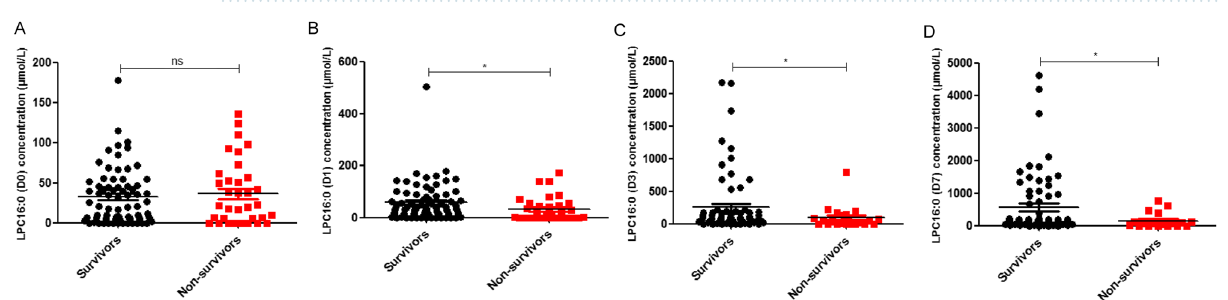
Figure 3. Comparison of LPC16:0 (D0–D7) concentration between survivors and non-survivors in sepsis patients (number of survivors and non-survivors; D0 73:40, D1 73:37, D3 73:28, D7 73:23, respectively). Data provided are the mean ± SEM, *P < 0.05, **P < 0.01, ***P < 0.001 analyzed by Student’s unpaired two-tailed t